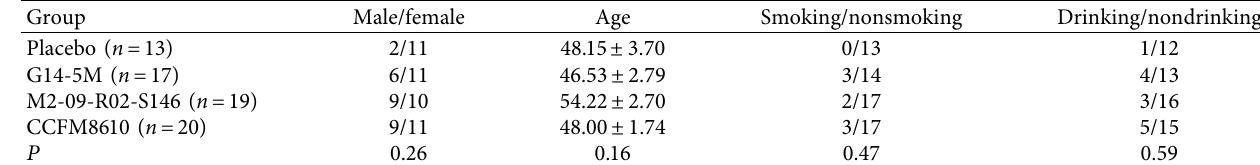
5M treatment group at the end of the trial (Figure 2).